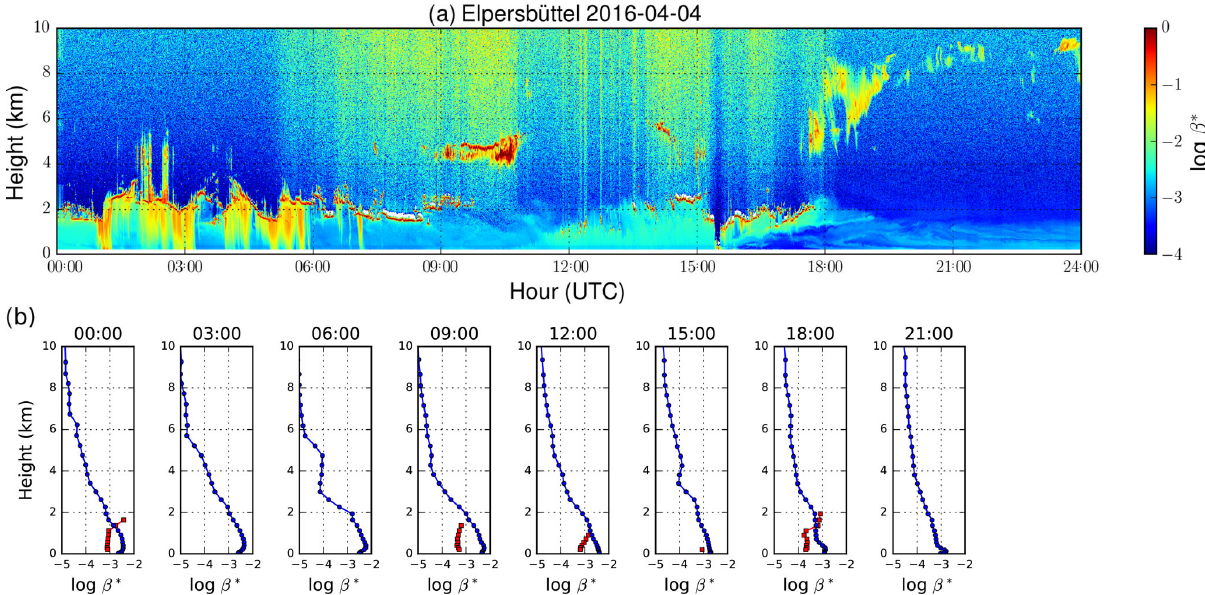
Figure 13. Same as Fig. 10 but for 4 April